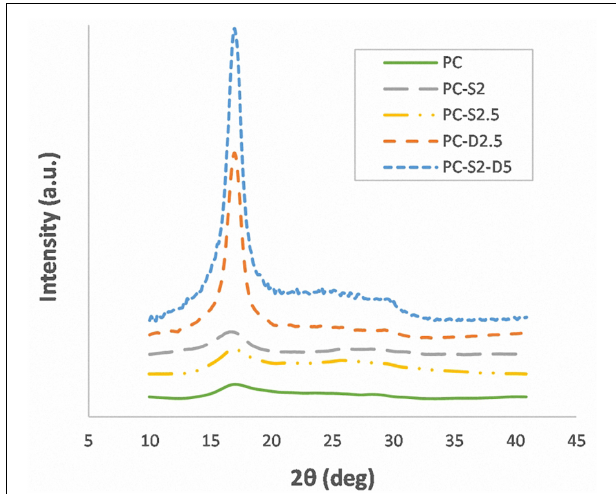
FIGURE 5 | XRD patterns of PAN/CNT fibers at different stretching conditions.